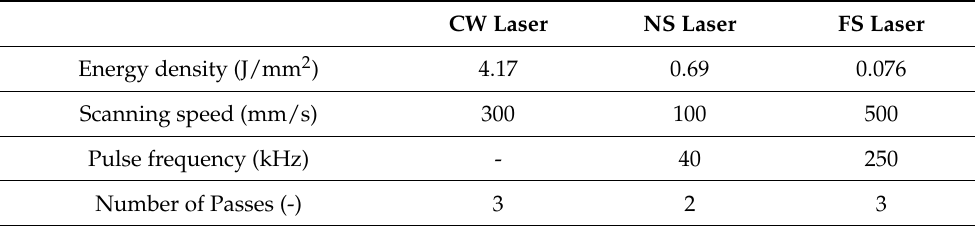
Figure 2. Actual images of the ( a ) CW, ( b ) FS, and ( c ) NS laser processing systems. Table 2. Parameters adopted for laser polishing.